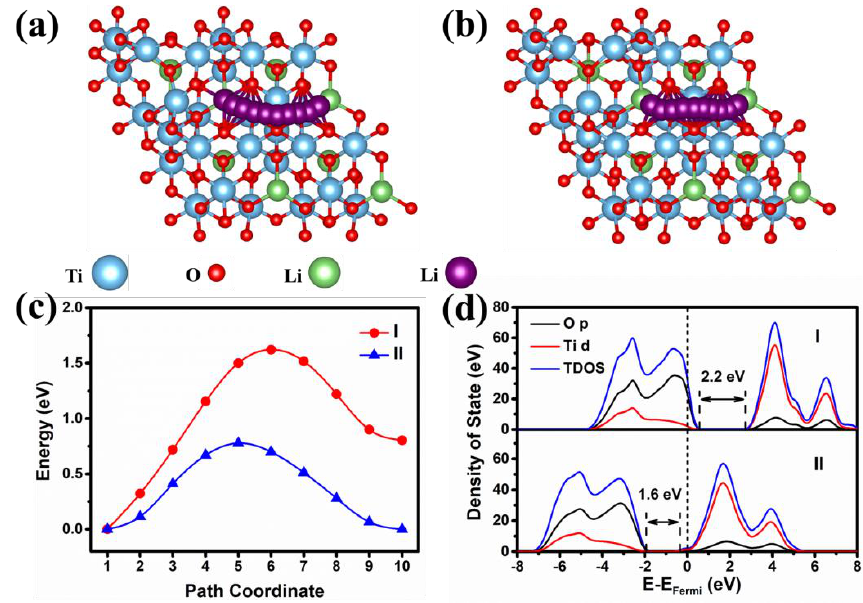
Figure 8. Li migration paths of ( a ) model I and ( b ) model II; ( c ) corresponding energy barriers and ( d ) calculated DOS of model I and model II. Model I and II correspond to the (111) surface of LTO with the OVs concentration of 3.9% and 7.8%, respectively.